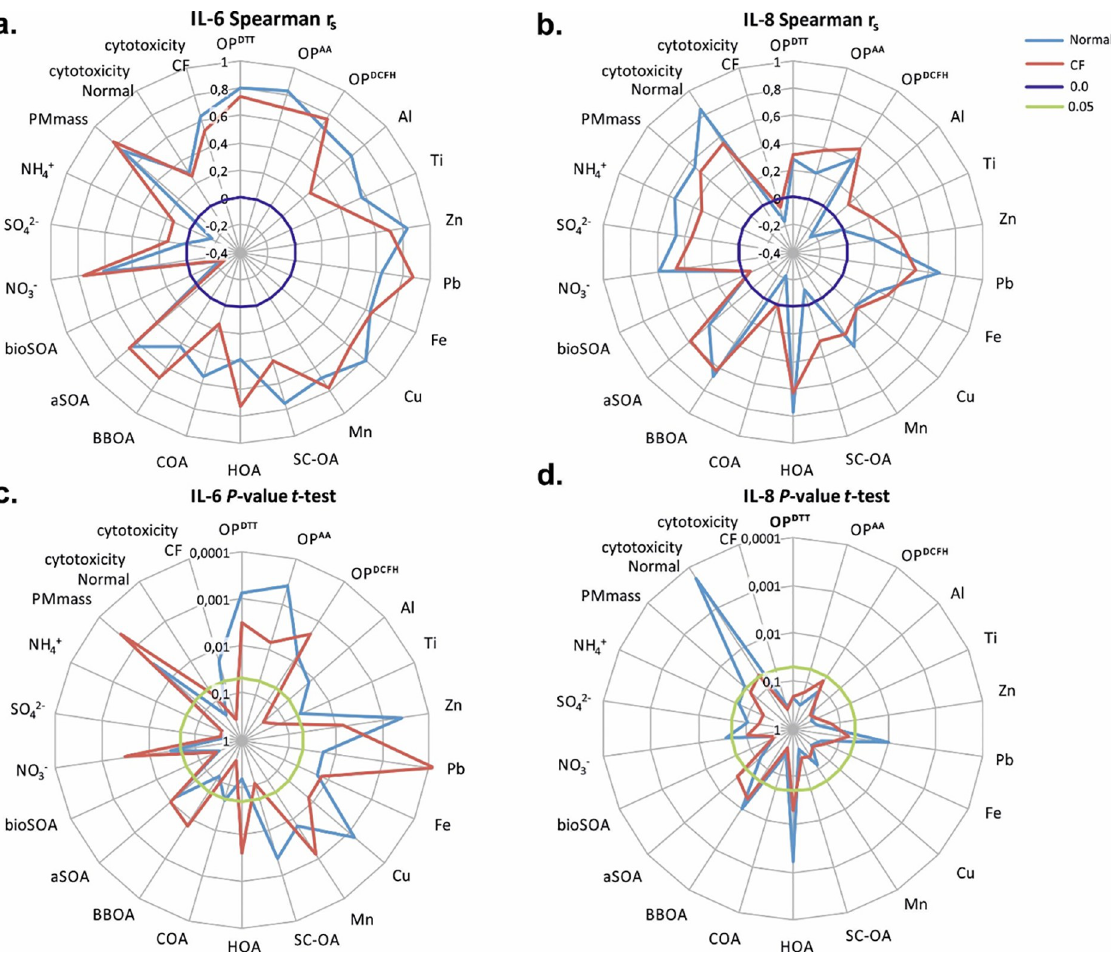
Fig 4. Association between cellular responses upon exposure to PM and chemical parameters of the PM. ( a ) and ( b ) non parametric correlation (Spearman